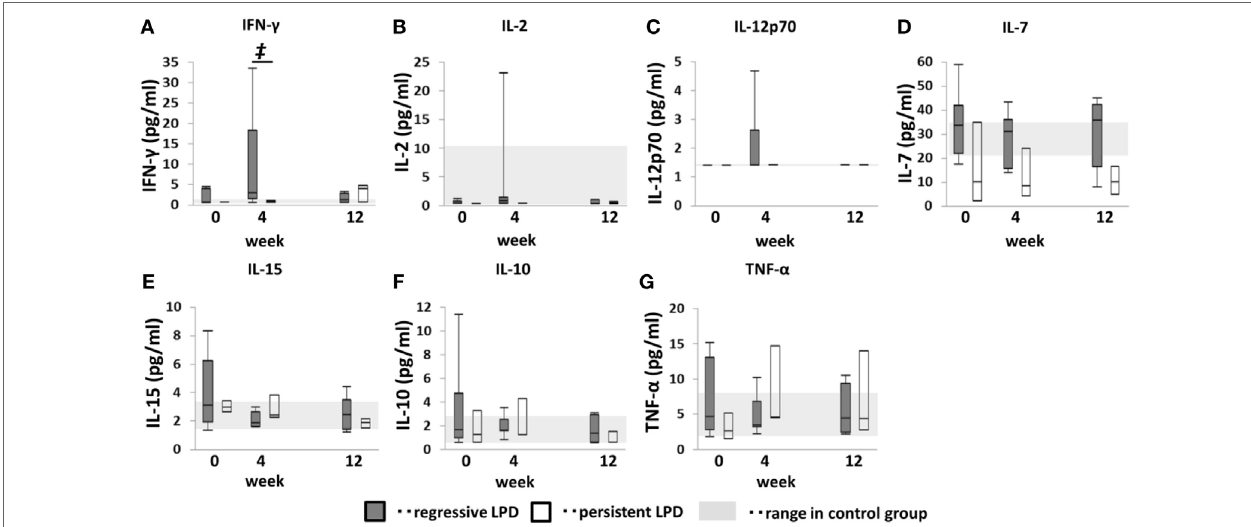
Figure 7 | Changes in serum cytokines after methotrexate (MTX) cessation in lymphoproliferative disorder (LPD) patients. Transition of (a) interferon (IFN)- γ , (B) IL-2, (c) IL-12p70, (D) IL-7, (e) IL-15, (F) IL-10, and (g) TNF- α after MTX cessation. Comparison between the three groups was conducted using the